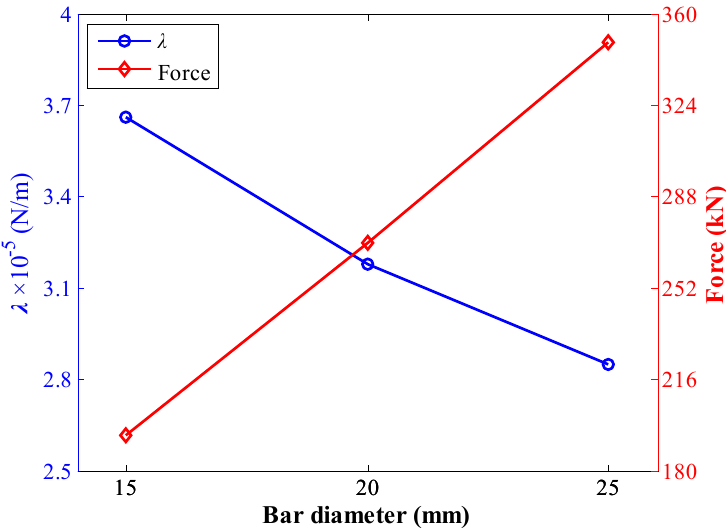
Figure 4. Relationship between the maximum force of the bars, λ , and the bar diameter.